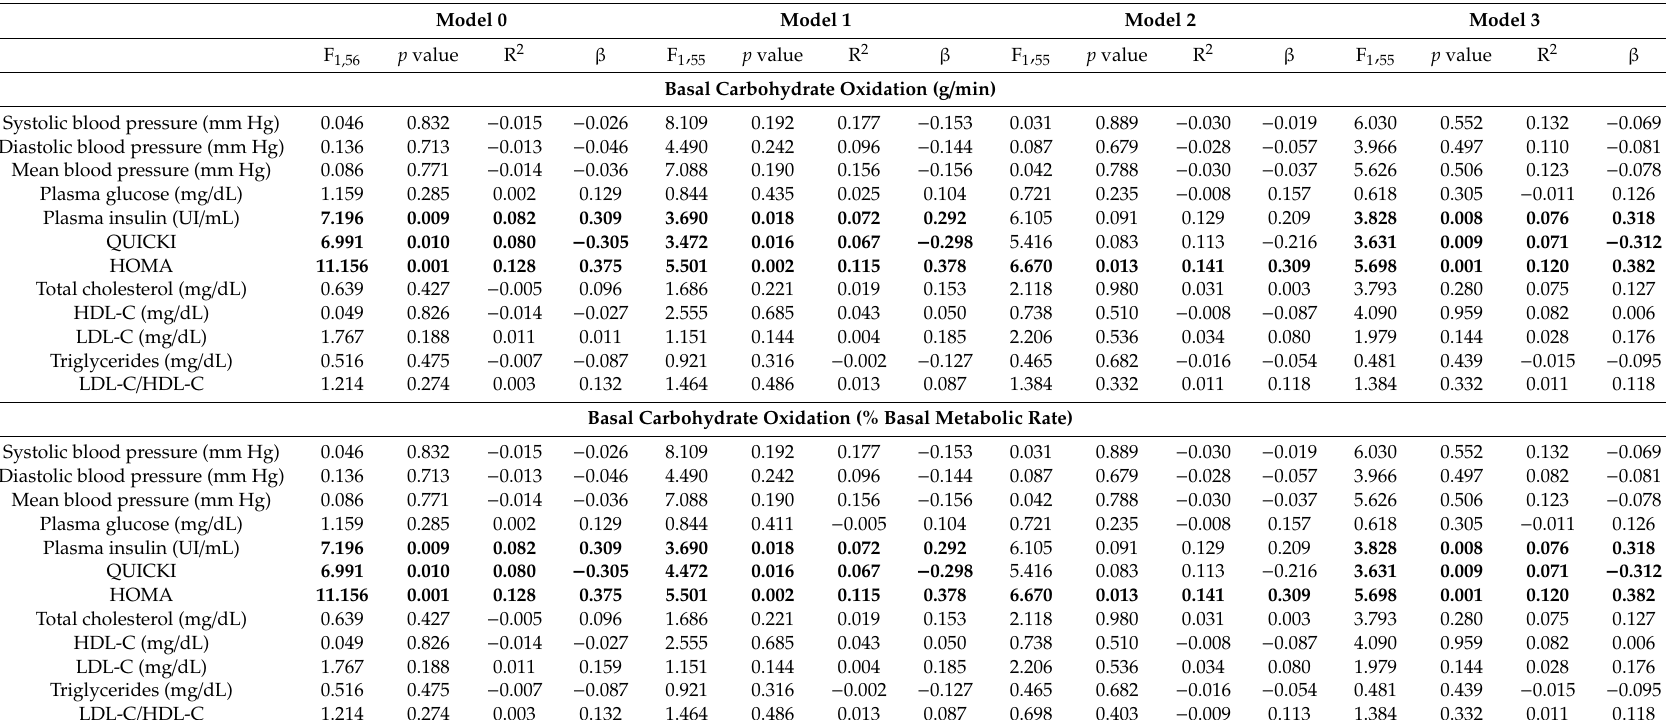
Table 3. Association of basal carbohydrate oxidation with cardiometabolic risk